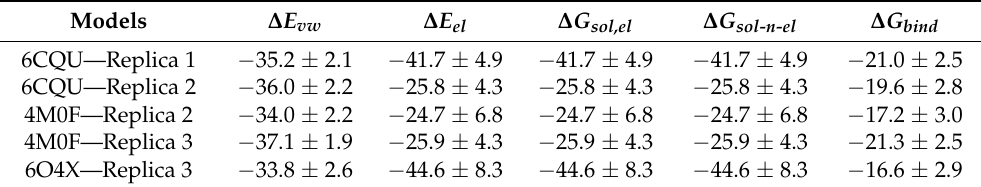
Table 6. Binding affinities ( K a ) and numbers of binding sites ( n ) for the interaction of apigenin and quercetin with AChE.